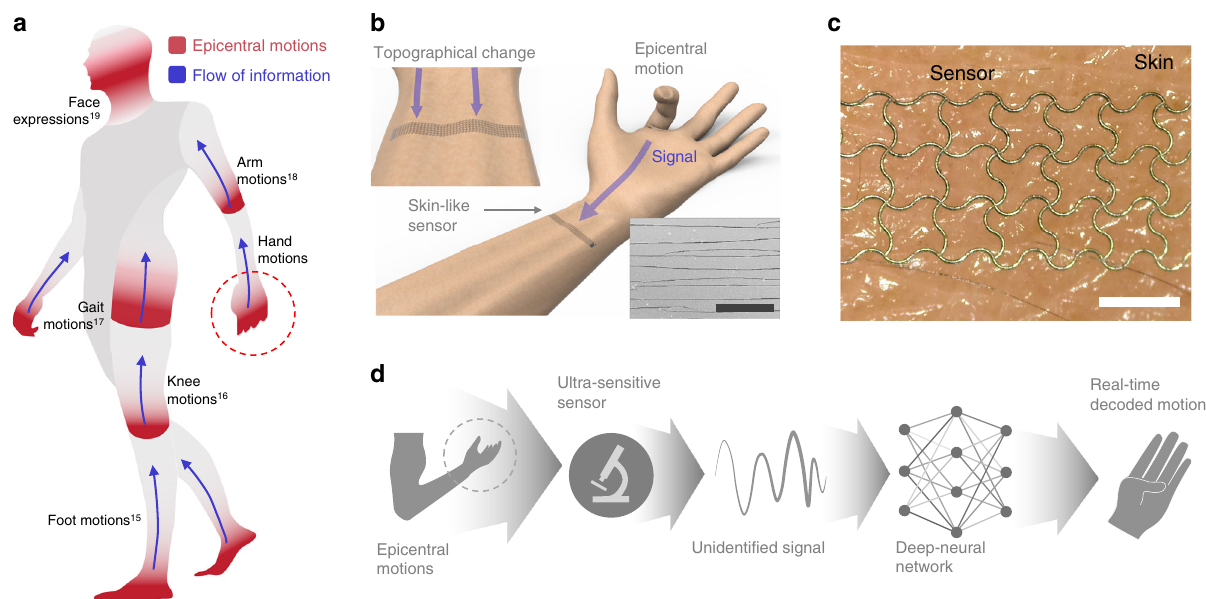
Fig. 1 Design of the deep-learned skin-like sensor. a Schematic depicting the possible fl ow of information through our body. The information may include foot, knee, hand, arm, gait, and also face expressions. b Illustration of measuring the epicentral motions of fi ngers. Upper left image depicts the measurement of the topographical change of the wrist caused by the fi nger motions. Lower right image shows the SEM image of the cracked region of the sensor. Scale bar, 40 μ m. c Magni fi ed image of the sensor conformably attached on skin. Scale bar 1 mm. d Design of the proposed sensory system.